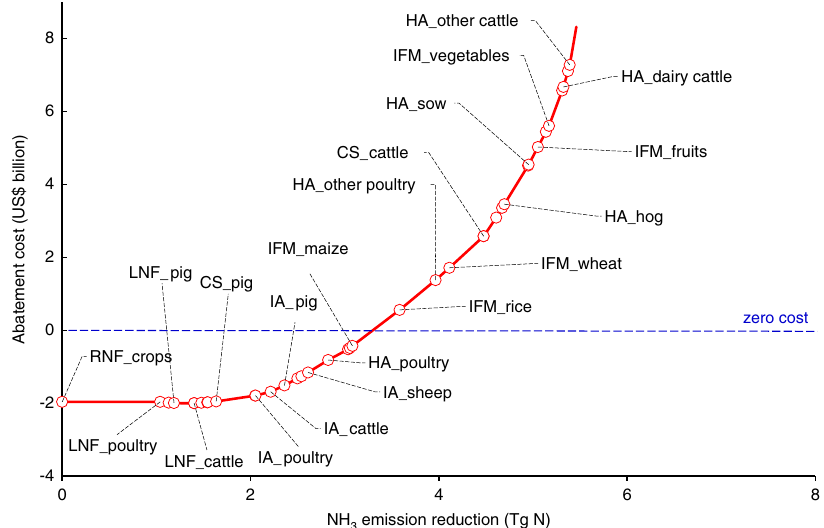
Fig. 1 Marginal abatement cost curve of agricultural NH 3 emissions in China. The red dots represent the introduction of speci fi c mitigation options. Only measures with a signi fi cant reduction potential (>0.1 Tg NH 3 – N) are labeled; the blue dotted line represents abatements cost = 0; the RNF is the direct reduction of synthetic N fertilizer (mainly urea) use on croplands without yield loss, since currently the high application rates of N fertilizer in China far exceed crop demand 31 ; LNF represents low N feeding options without decreasing animal productivity; CS represents covered storage measures; IA represents improved manure application options; HA represents housing adaptation options; IFM means improved fertilization management including right source, right place, right time of fertilization and irrigation. Note that in this fi gure we only give the weighted mitigation potential and weighted cost of the proposed mitigation options for different crops or animals. Details about combinations of mitigation measures are summarized in Supplementary Table 7. Source data are provided as a Source Data fi